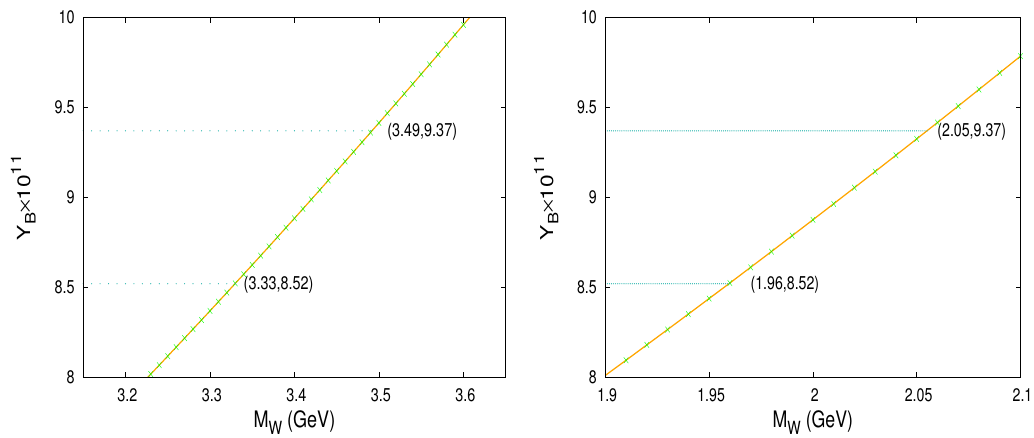
Figure 11 . Variation of (cid:12)nal Y B with M w where the set of parameters f k; Re( z ) ; Im( z ) M 2 kept (cid:12)xed at their best (cid:12)t value. In the left panel, pure N 2 contribution has not been considered whereas the plot of right panel takes into account this new